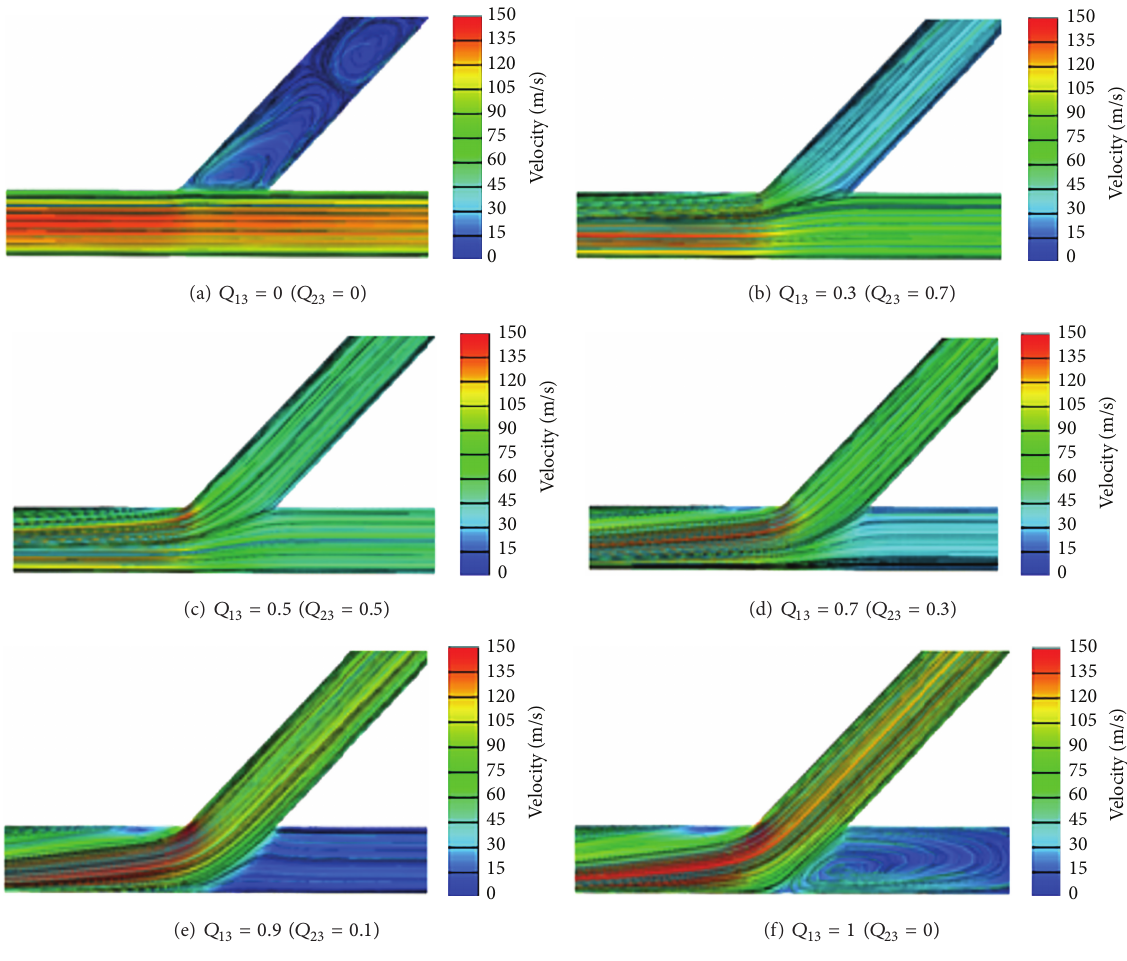
Figure 14: Velocity flow fields of junction with different ratio of flow rate at 𝑀 3 = 0.34 .